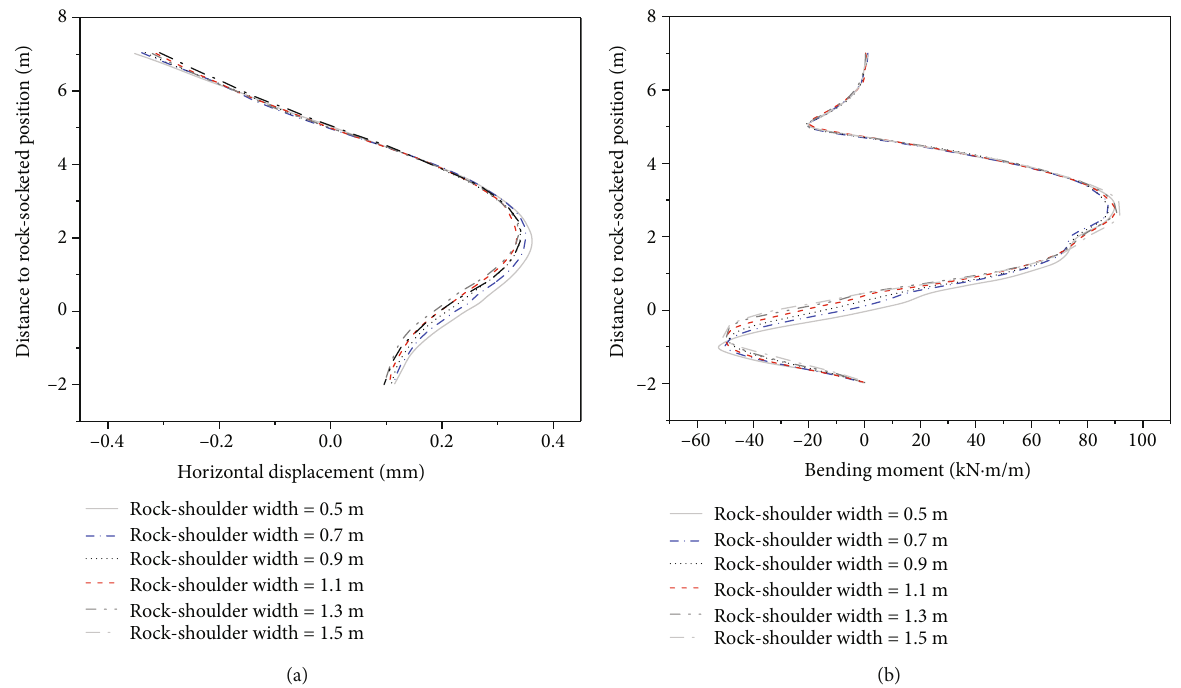
Figure 23: E ff ects of rock-shoulder width on the horizontal displacement and bending moment of the end-suspended pile. (a) Horizontal displacement. (b) Bending moment.